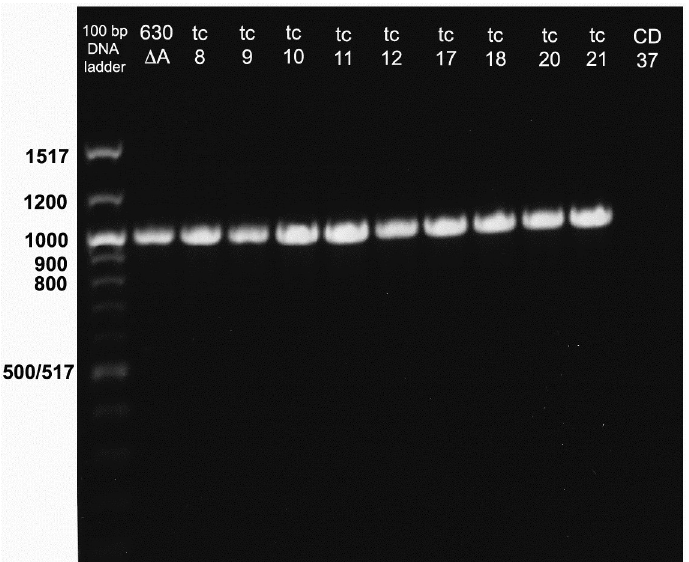
Fig 3. PCR amplification of 3’ tcd B nested 1004 bp sequence using primers 3pB-nu and 3pB-nd. Lane 1; 100 bp DNA ladder with the donor strain 630 Δ A in the next lane followed by 9 transconjugants (Tc 8–12, 17, 18, 20 and 21) and NTCD strain CD37 in the last